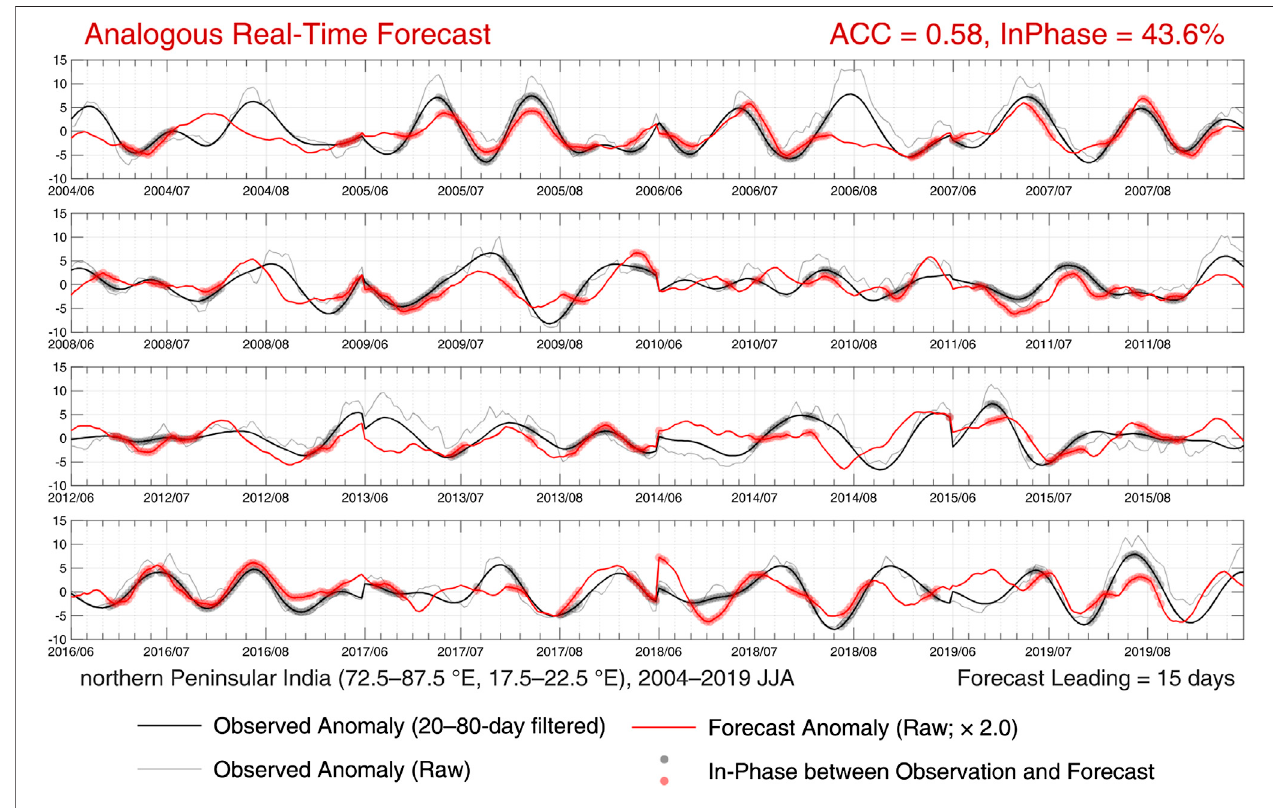
FIGURE 7 | Same as in Figure 5 , but the raw forecast anomalies are displayed. A forecast time-series from 30 days before to a particular moment is used to estimate the forecast instantaneous phase at that moment.